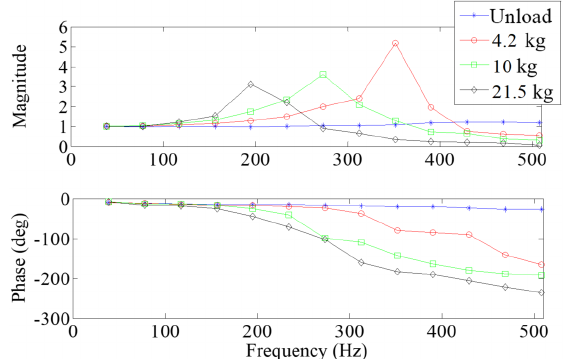
Figure 5. Normalized magnitude and phase responses of unloaded and loaded magnetostrictive actuated system in the 1–500Hz fre- quency